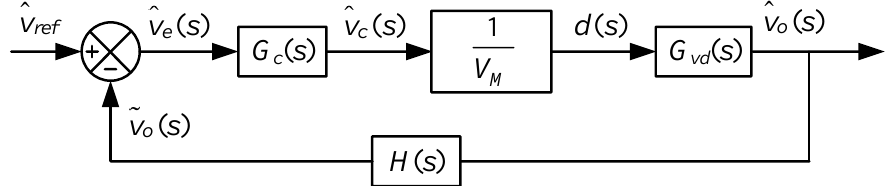
Figure 12. System block diagram for voltage feedback control of the proposed circuit.